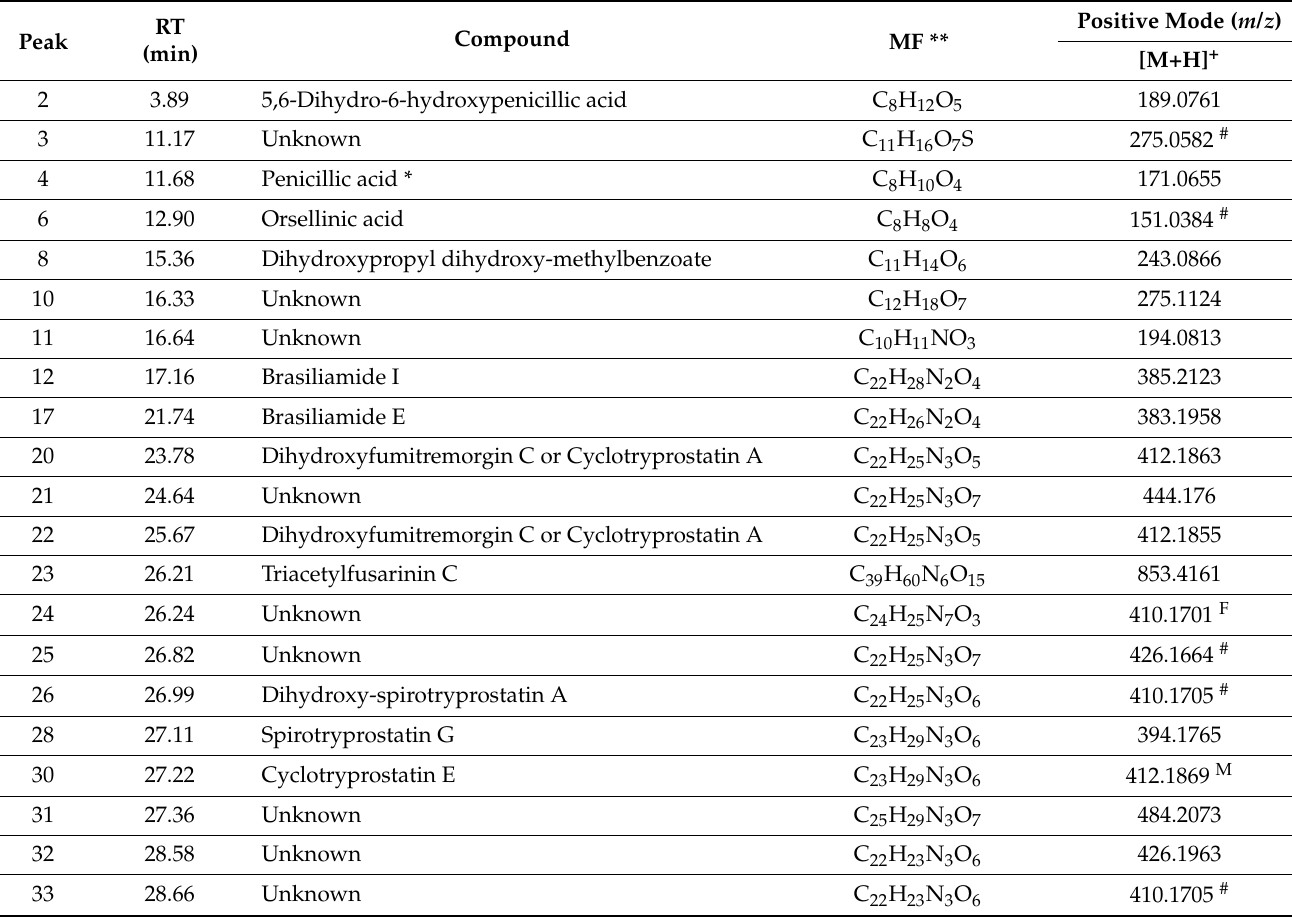
Table 1. Metabolites annotated from the crude extracts of Penicillium sp. 5MP2F4 by HPLC-DAD- MS/MS and their spectral